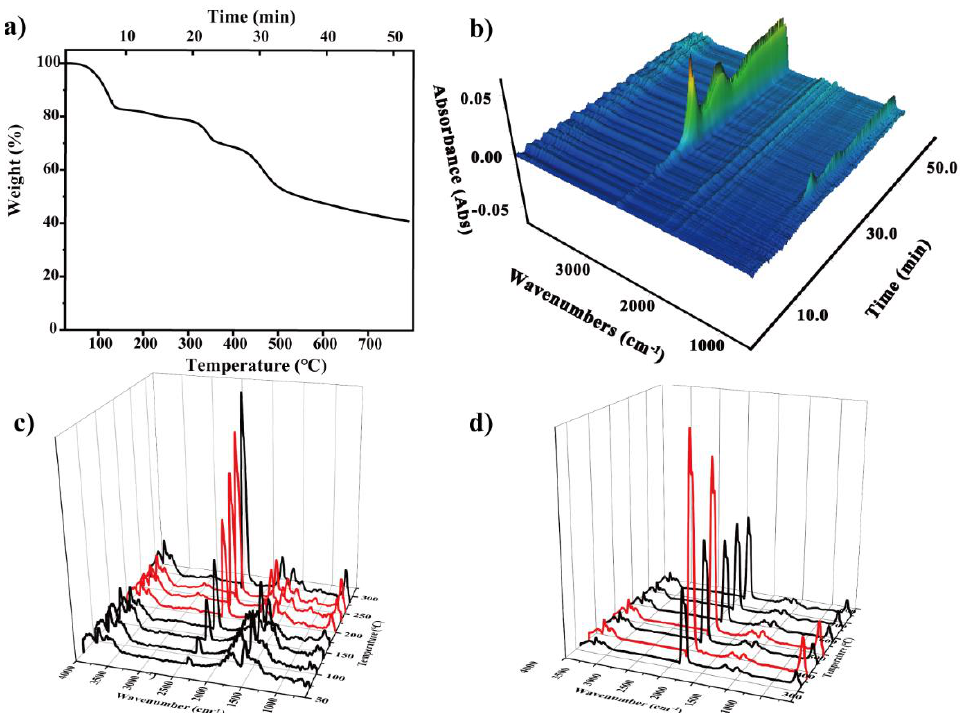
Figure 6. ( a ) Thermogravimetric diagram and ( b ) the thermogravimetric infrared three-dimensional diagram of COF-TpPa-1; Infrared images in the temperature ranges ( c ) 0–300 °C and ( d ) 300–800 °C of COF-TpPa-1.